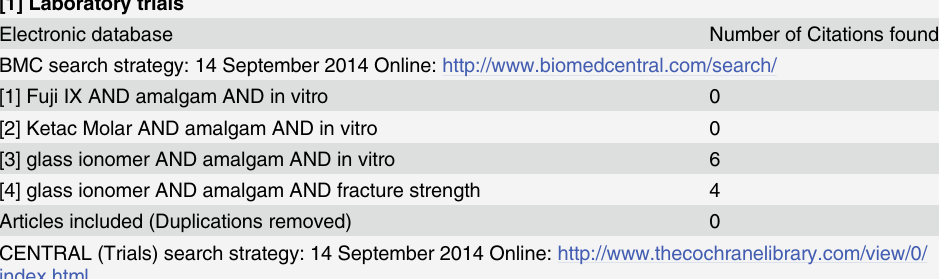
Table 1. Search strategy and results: electronic database